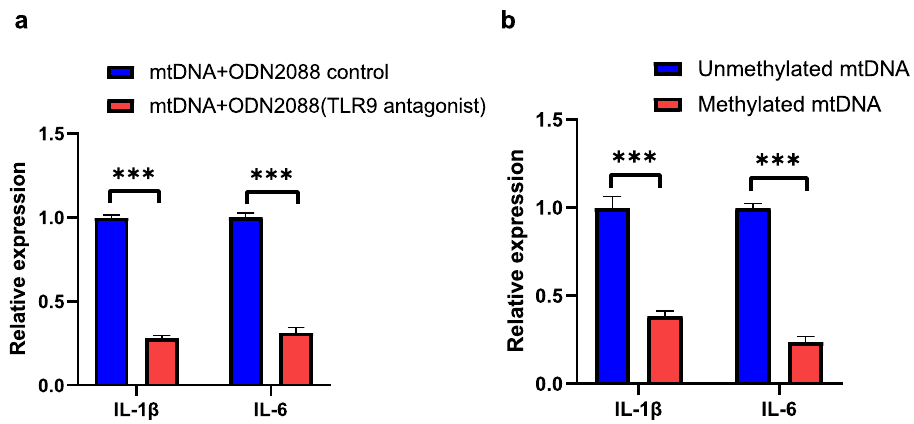
Figure 6. Sparsely methylated mt-cfDNA induced IL-1β and IL-6 expression in macrophages via TLR9. ( a ) Comparison of IL-1β and IL-6 expression levels between TLR9 inhibitor vs. ODN control under mitochondrial DNA exposure (500 ng/mL) (n = 4–6). ( b ) Comparison of IL-1β and IL-6 expression levels between fully methylated mitochondrial DNA (500 ng/mL) versus totally unmethylated mitochondrial DNA (500 ng/mL) (n = 6). Unpaired t test was performed for ( a ) and ( b ) *** p < 0.001.